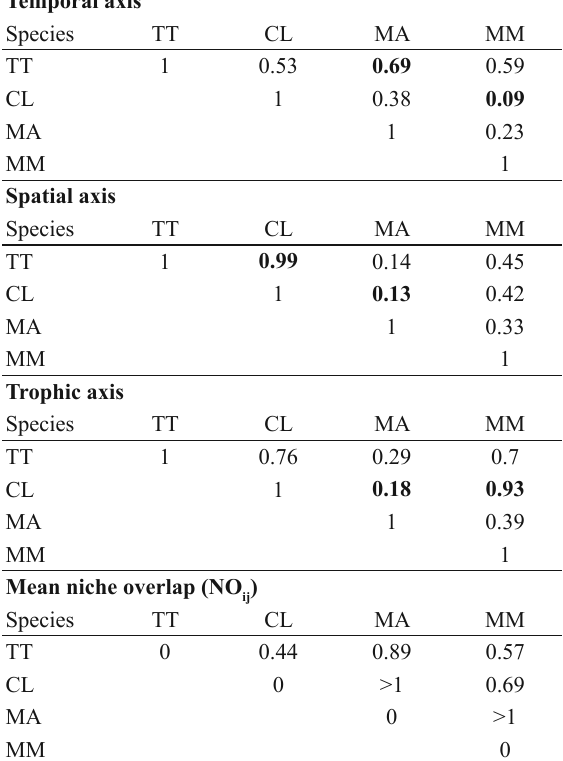
Observed overlap indices for time of activity (temporal axis), microhabitat use (spatial axis), and diet (trophic axis) for four lizard species, in Jurubatiba National Park, Rio de Janeiro State, Brazil. TT = Tropidurus torquatus ; CL = Cnemidophorus littoralis ; MA = Mabuya agilis ; MM = M. macrorhyncha . NO = estimated pairwise niche ij overlap considering all niche axes. Numbers in bold represent the highest and the lowest